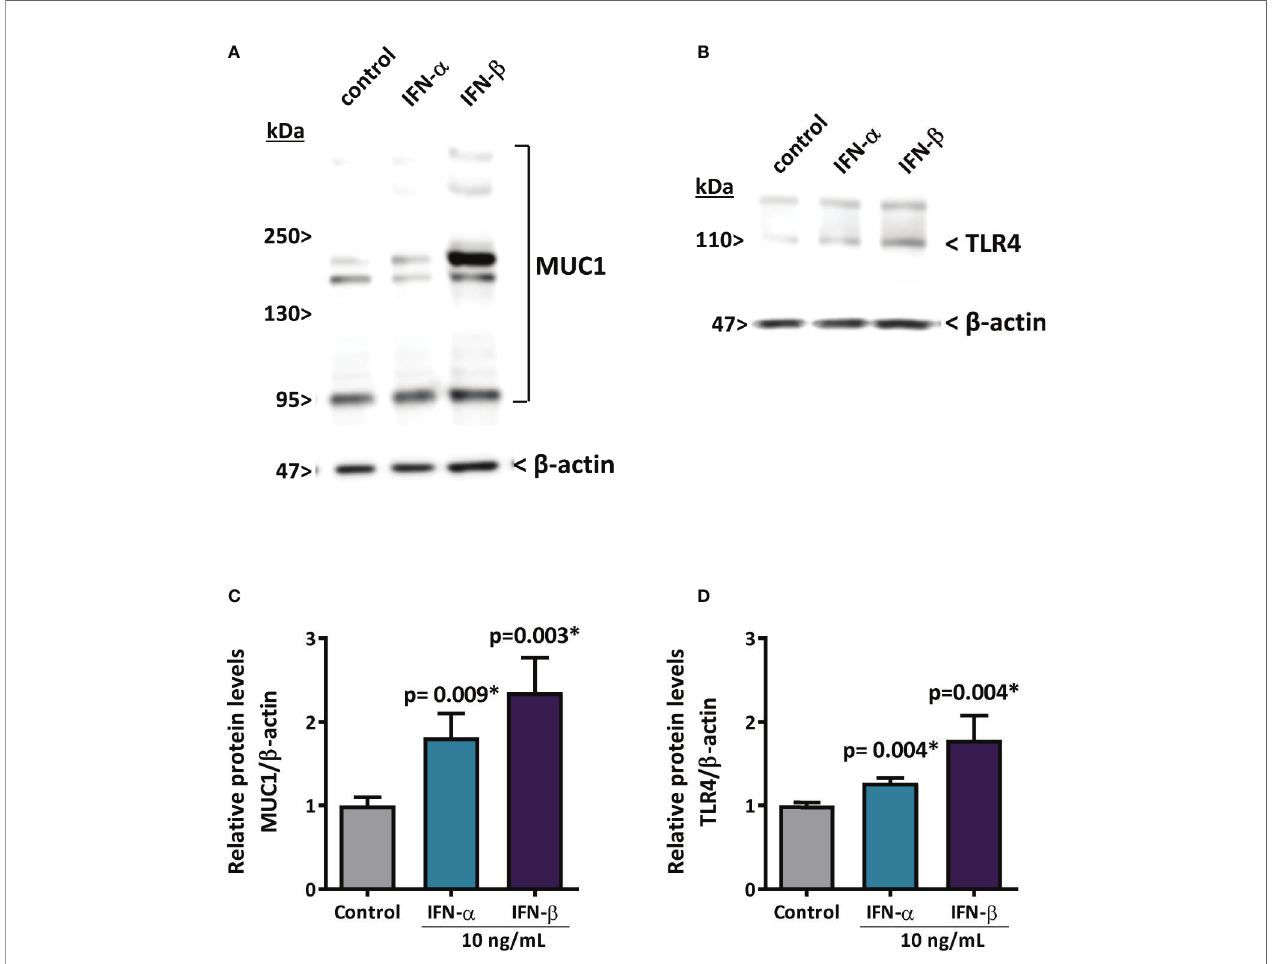
FIGURE 6 | IFN- a and IFN- b increase MUC1 and TLR4 protein levels in HSG cells. (A, C) representative MUC1 western blot (90-300 kDa) in HSG cells stimulated with 10 ng/mL IFN- a or IFN- b for 24 h. Relative protein levels were normalized to the control condition. b -actin was used as a loading control. (B, D) representative TLR4 western blot (95 kDa) in HSG cells stimulated with 10 ng/mL IFN- a or IFN- b for 24 h. Relative protein levels were normalized to the control condition. b -actin was used as a loading control. Data are representative of at least three independent experiments. (*) p-value ≤ 0.05 was considered signi fi